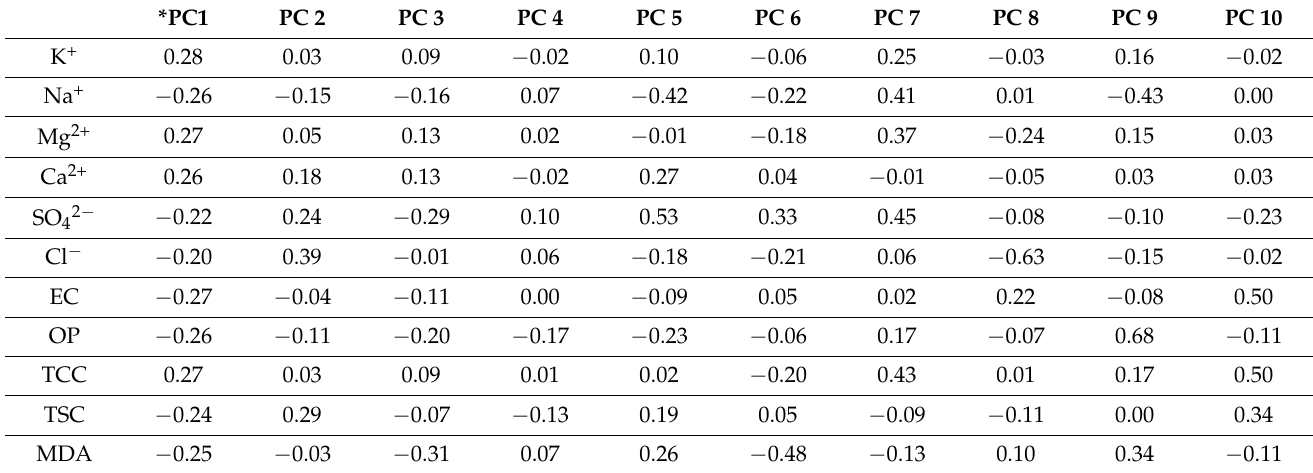
Table 7. Eigenvectors of the principal components using four sorghum lines and eighteen